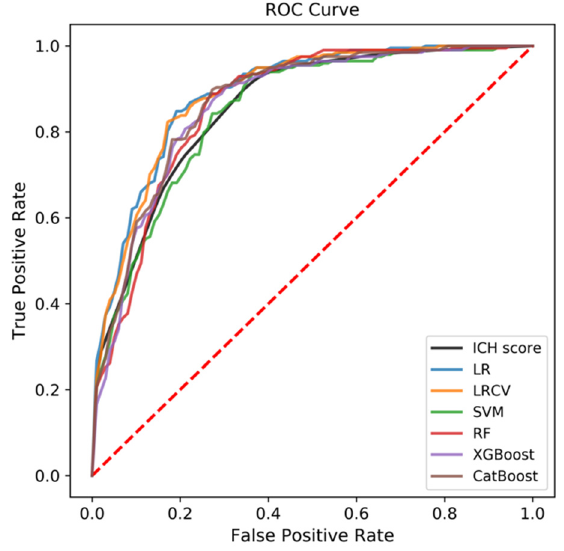
Figure 1. Flowchart of SICH patient inclusion and exclusion.